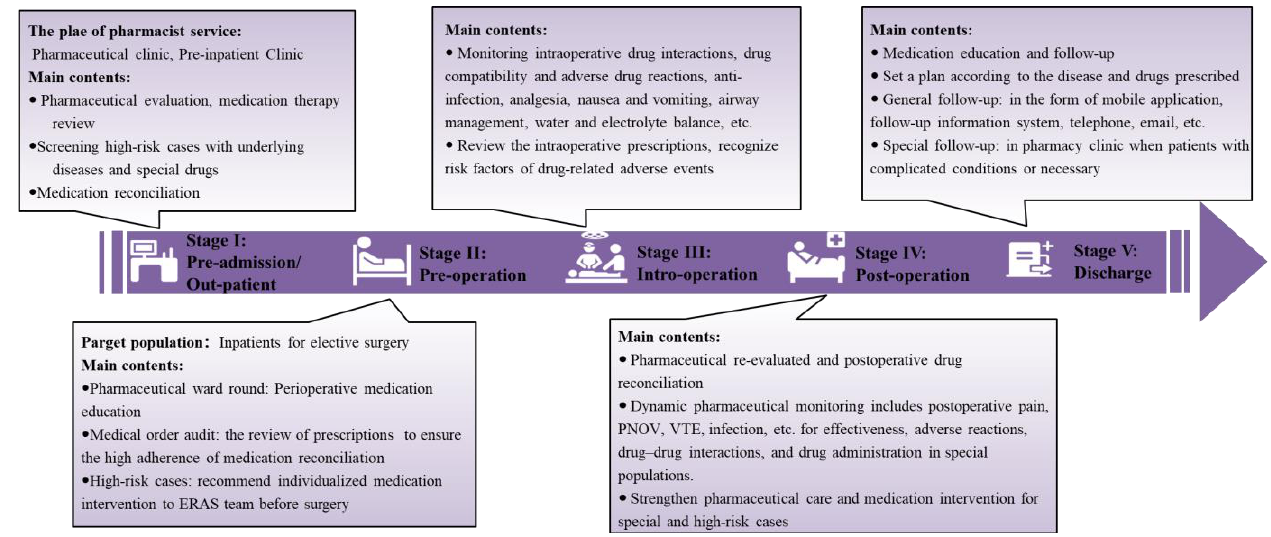
Figure 2. Workflow chart for surgical pharmacists in perioperative medication treatment management within ERAS programs. PONV: postoperative nausea and vomiting; VTE, venous thromboembolism.